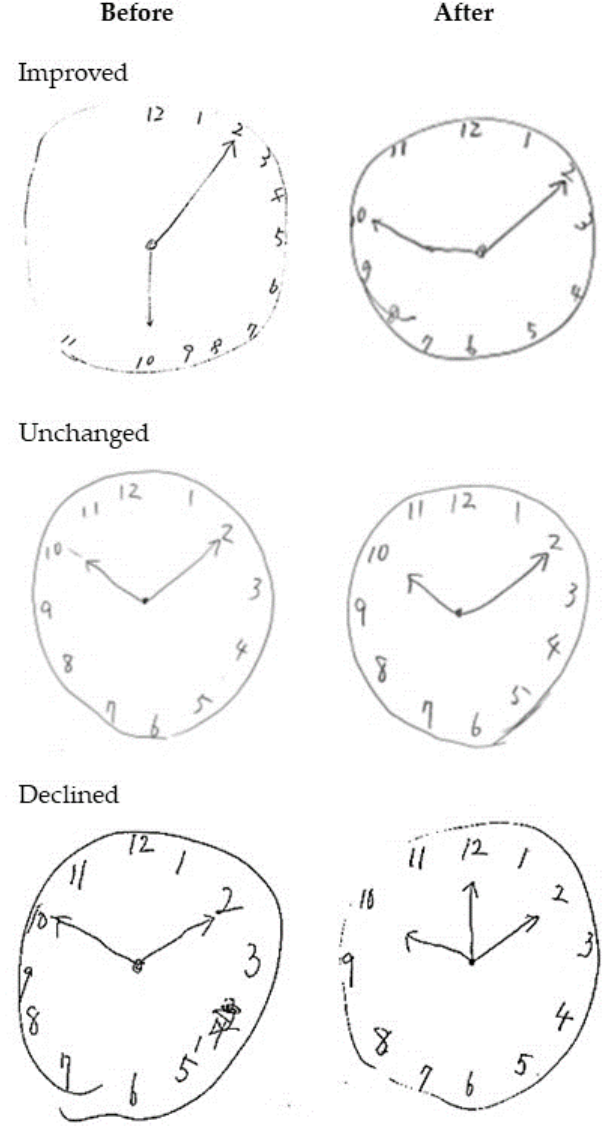
Figure 4. Examples of changes in Clock Drawing Test.